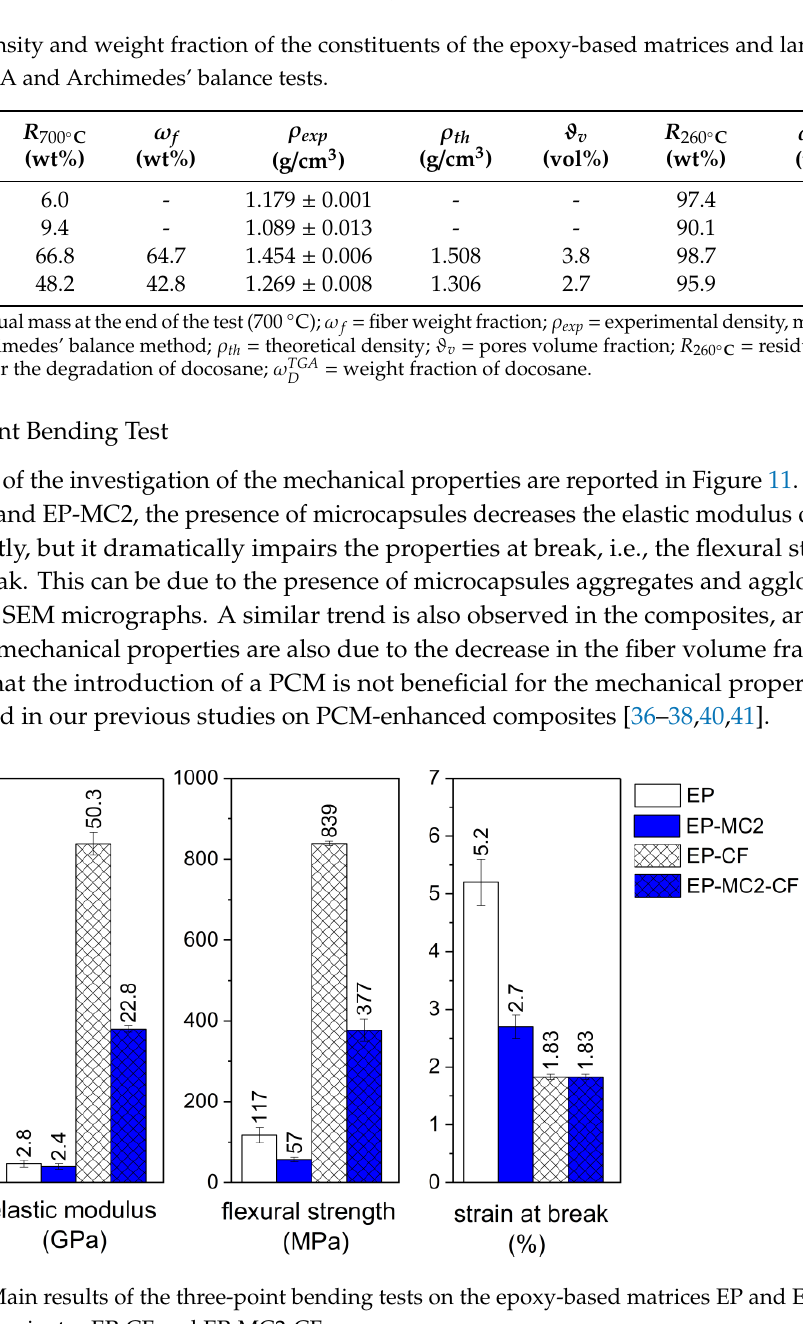
Table 4. Density and weight fraction of the constituents of the epoxy-based matrices and laminates from the TGA and Archimedes’ balance tests.